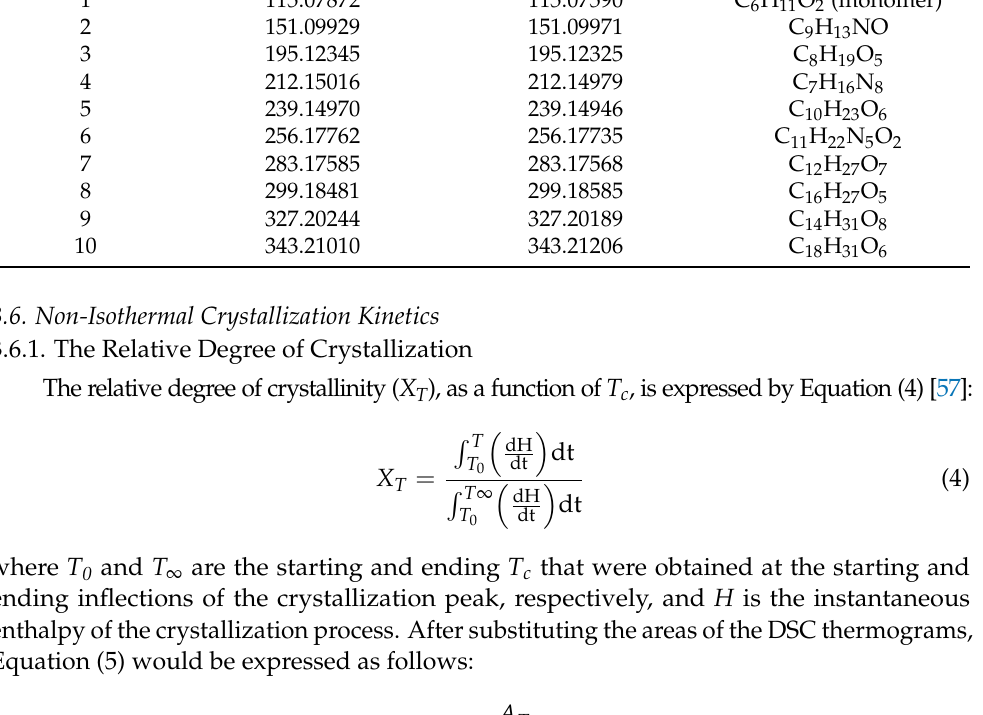
Table 7. Principal fragments obtained by the isothermal decomposition of E-VAL/PCL50. N o Experimental Mass Calculated Mass